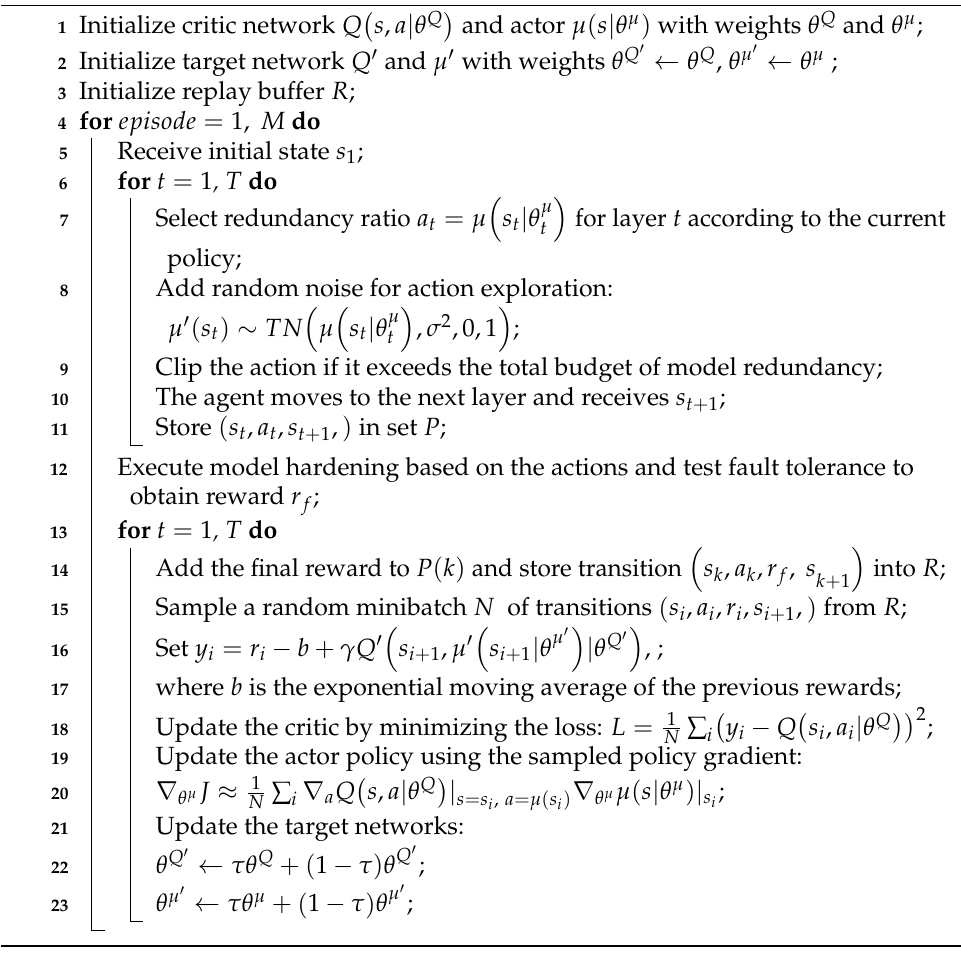
Algorithm 1: DDPG training